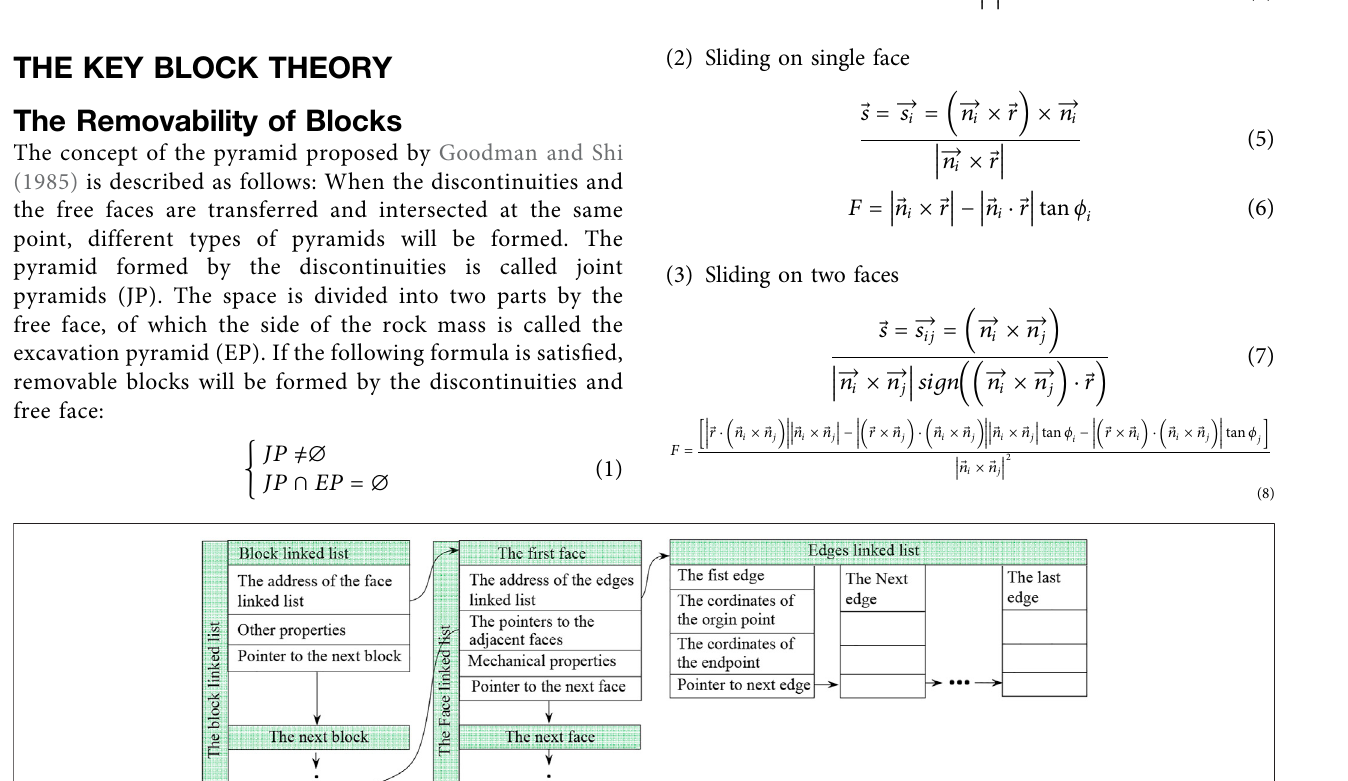
FIGURE 3 | Storage mode of the block data.